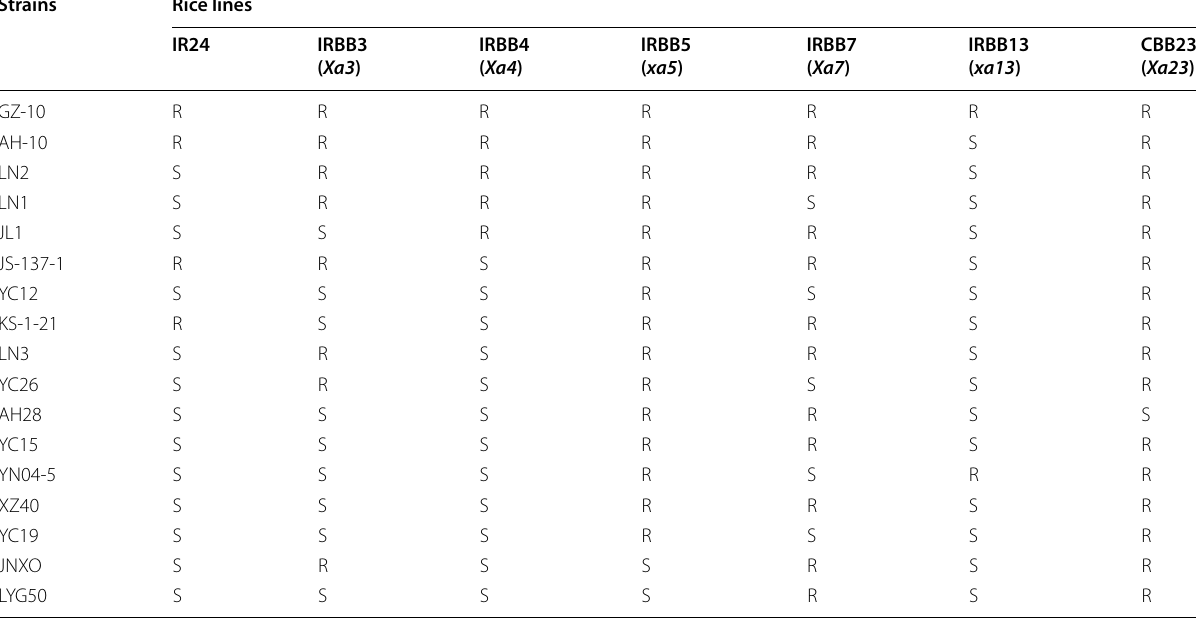
S, susceptible (the lesion length of BB is more than 2 cm); R, resistant (less than 2 cm)